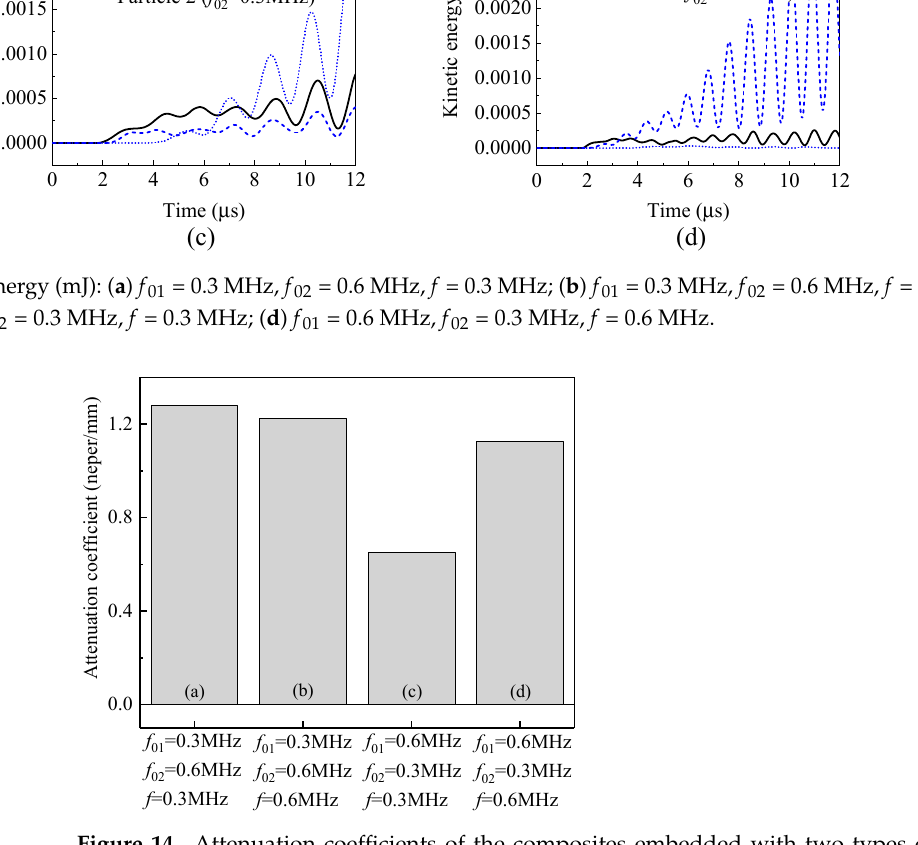
Figure 14. Attenuation coefficients of the composites embedded with two types of particles of different natural frequencies: ( a ) f 01 = 0.3 MHz, f 02 = 0.6 MHz, f = 0.3 MHz; ( b ) f 01 = 0.3 MHz, f 02 = 0.6 MHz, f = 0.6 MHz; ( c ) f 01 = 0.6 MHz, f 02 = 0.3 MHz, f = 0.3 MHz; ( d ) f 01 = 0.6 MHz, f 02 = 0.3 MHz, f = 0.6 MHz.